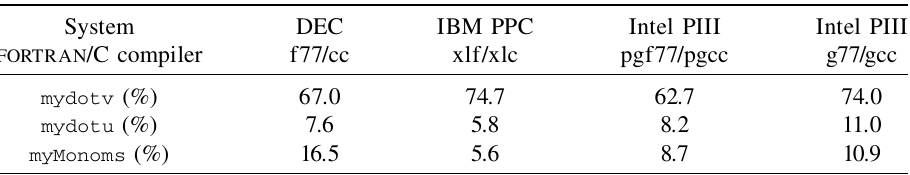
TABLE III. Percentage of time spent in selected FORTRAN -optimized